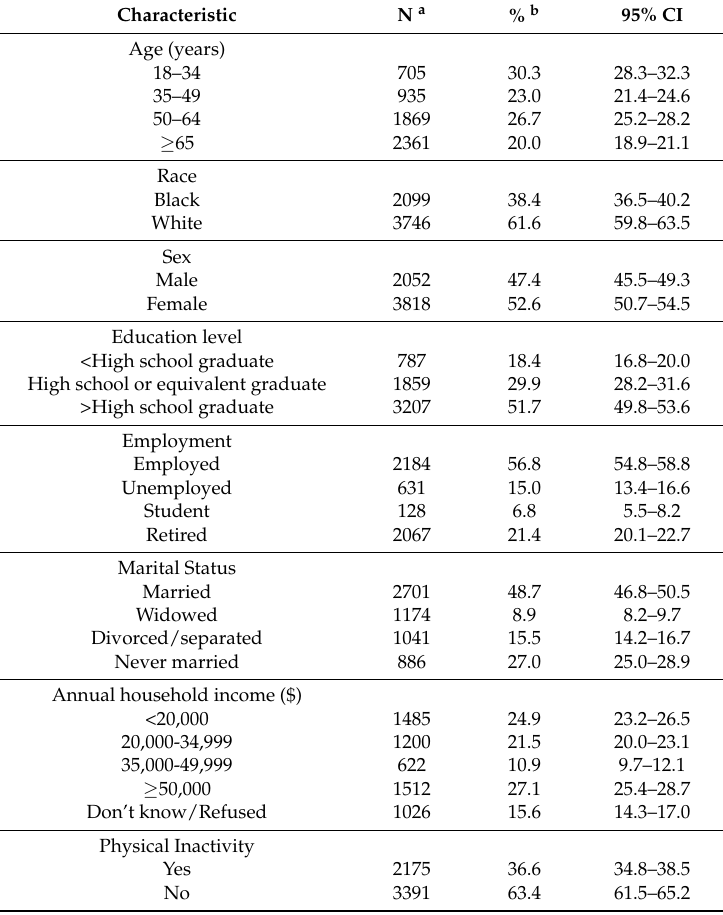
Table 1. Sociodemographic characteristics of Mississippi adults, Behavioral Risk Factor Surveillance System,